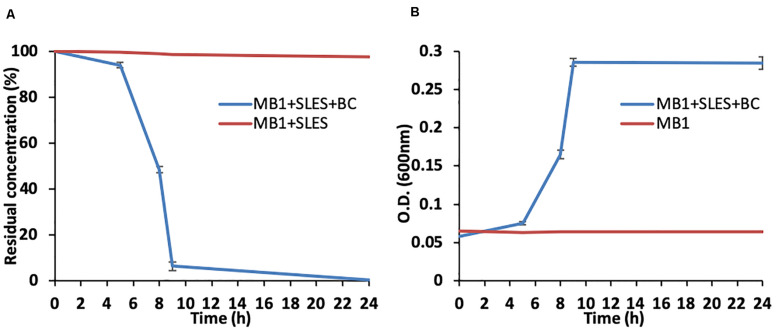
SLES biodegradation experiment. (A) SLES decrease due to the bacterial consortium over time (0–24 h). (B) Bacterial consortium growth measured as O.D. (600nm). The vertical bars are the standard errors. MB1 = negative control.